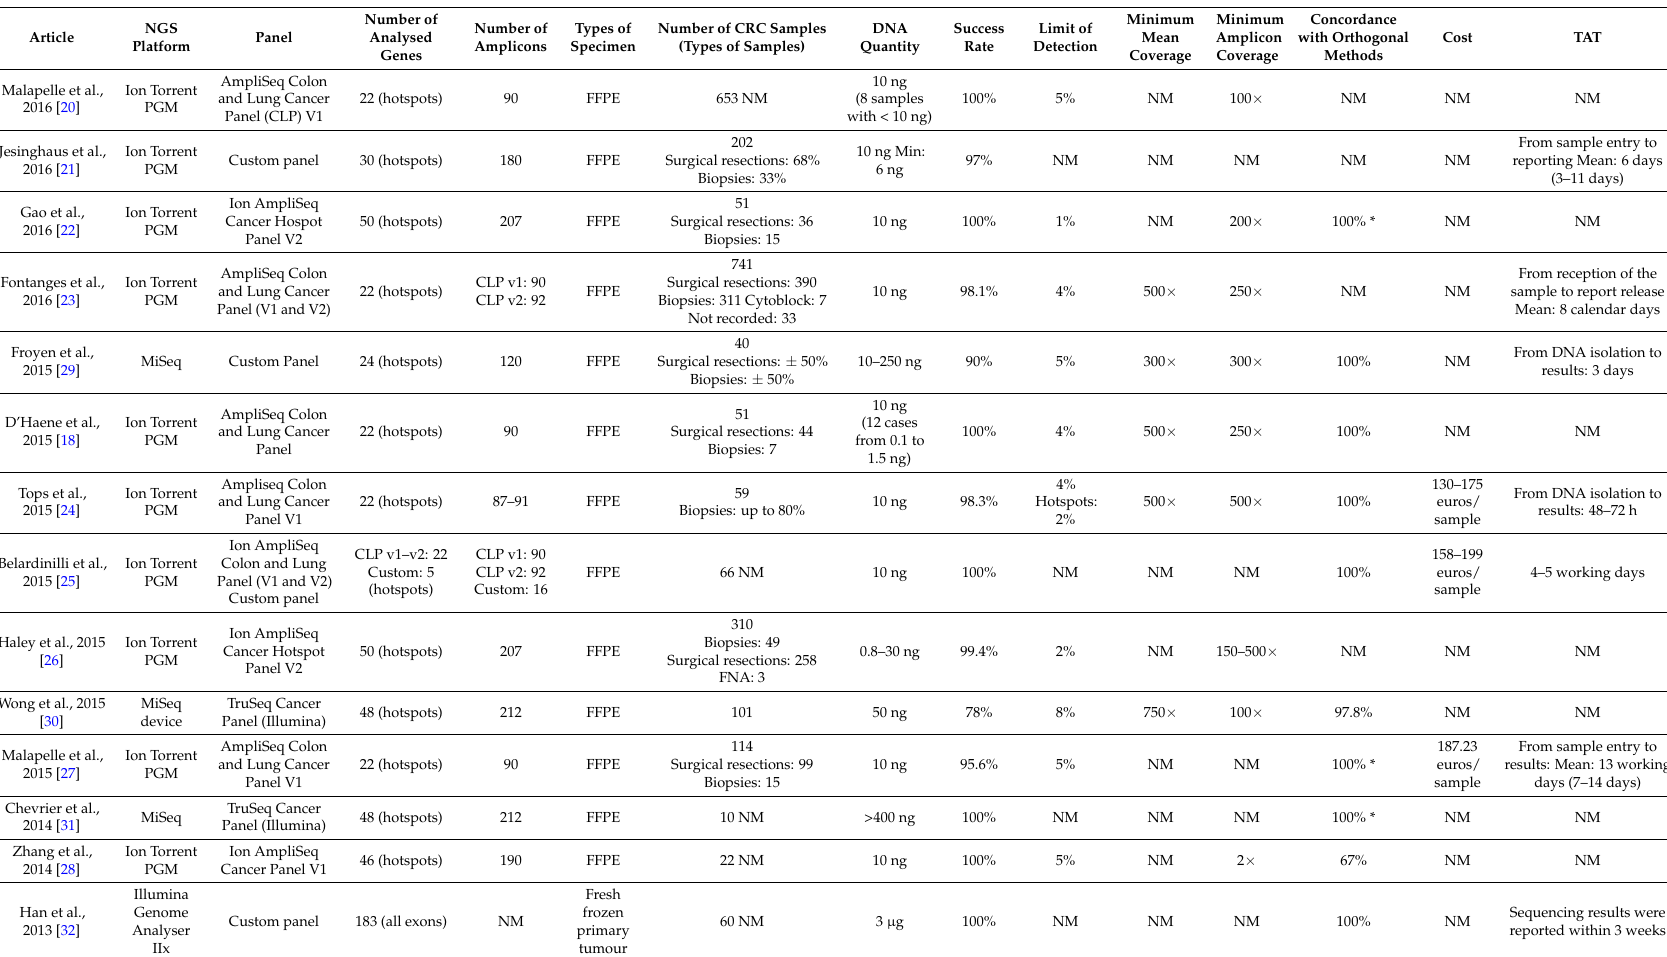
Table 1. Overview of the studies using next generation sequencing for colorectal cancer patients in a clinical